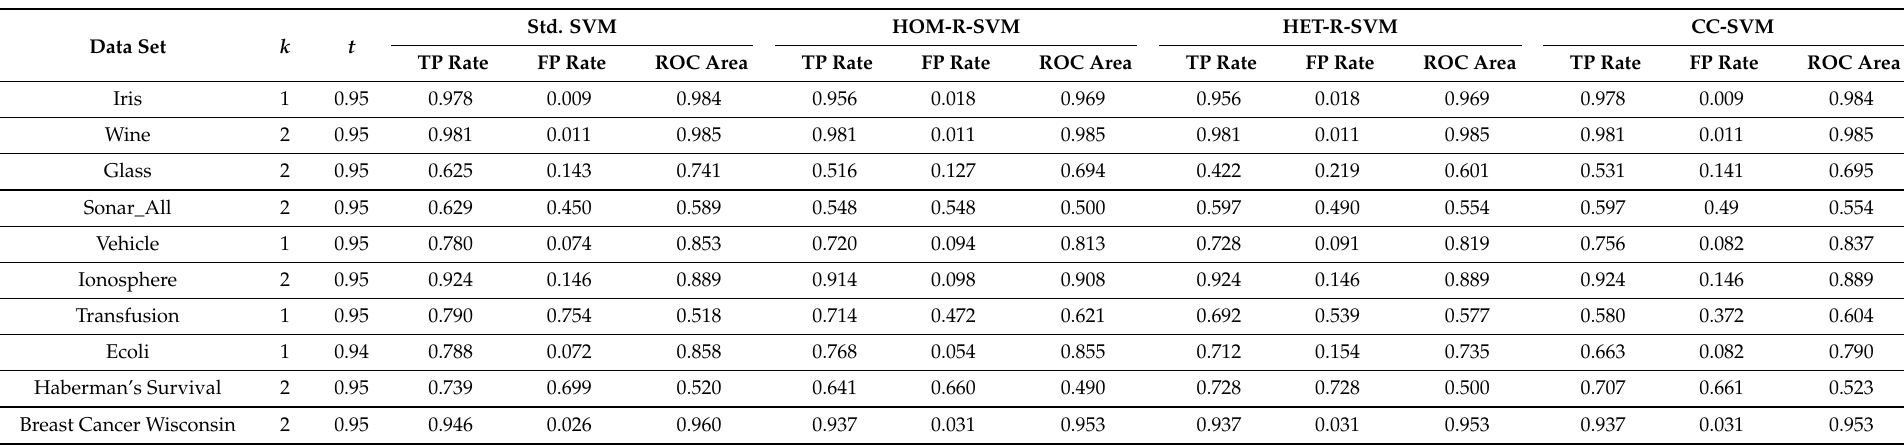
Table 4. TP rates, FP rates and AUC